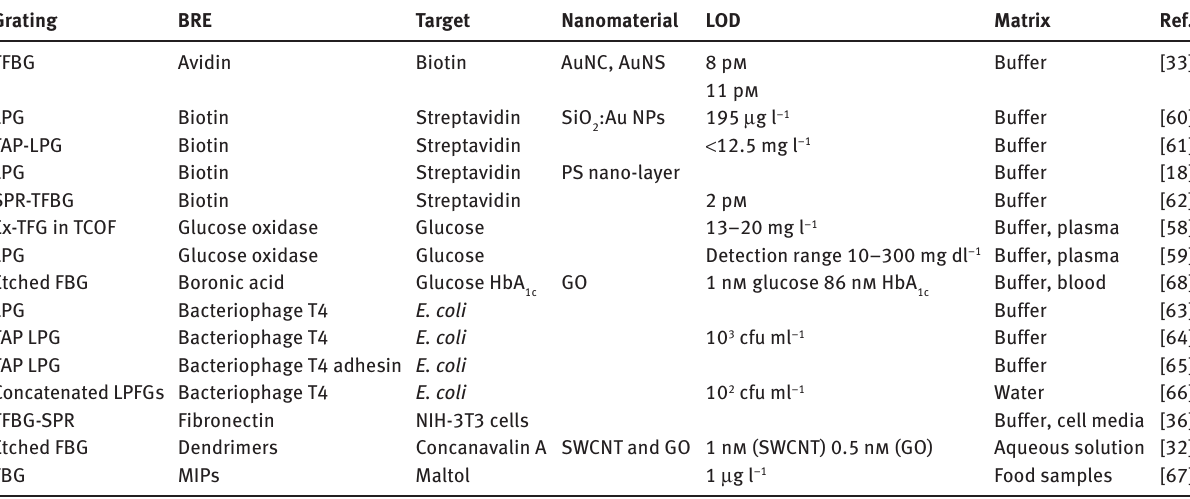
Table 3: OFG-based biosensors with other biomolecules as BREs.